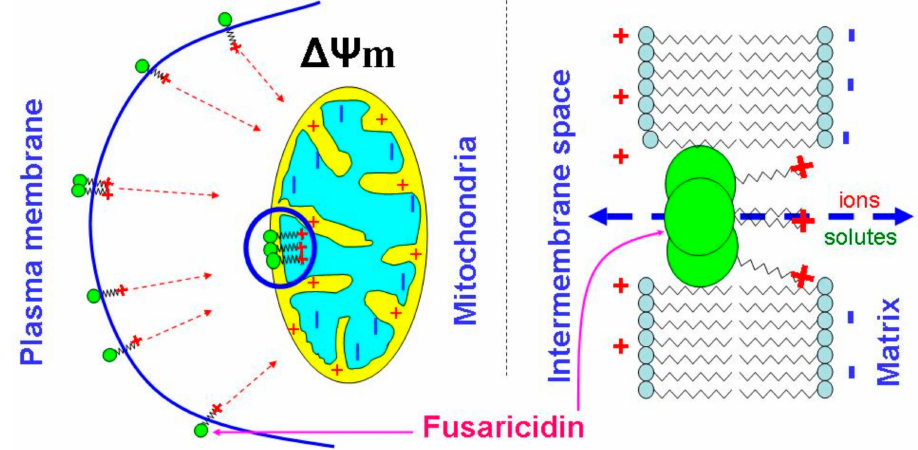
Figure 8. Probable role of the guanidine moiety in the ∆Ψ m -dependent creation of fusaricidin pores in mitochondrial and plasma